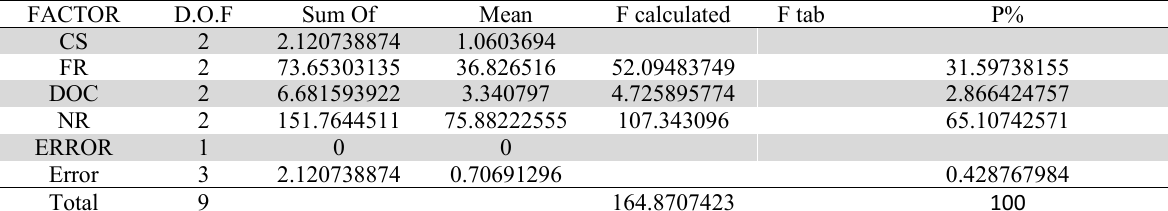
ANOVA Results for R a